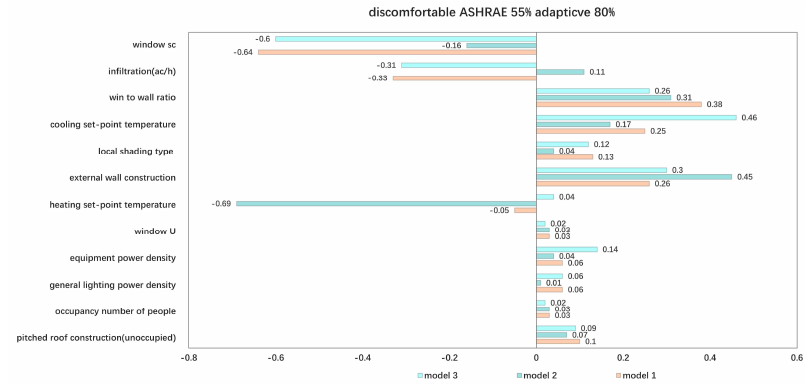
Figure 18. SRC for each parameter for 55% of discomfortable ASHRAE.